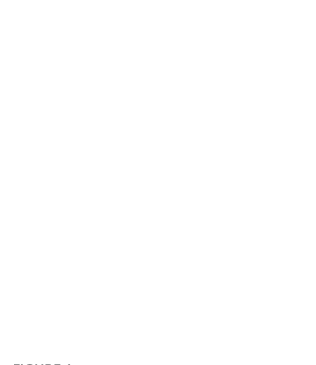
FIGURE 1 Bland – Altman plot of the 3L and 5L index